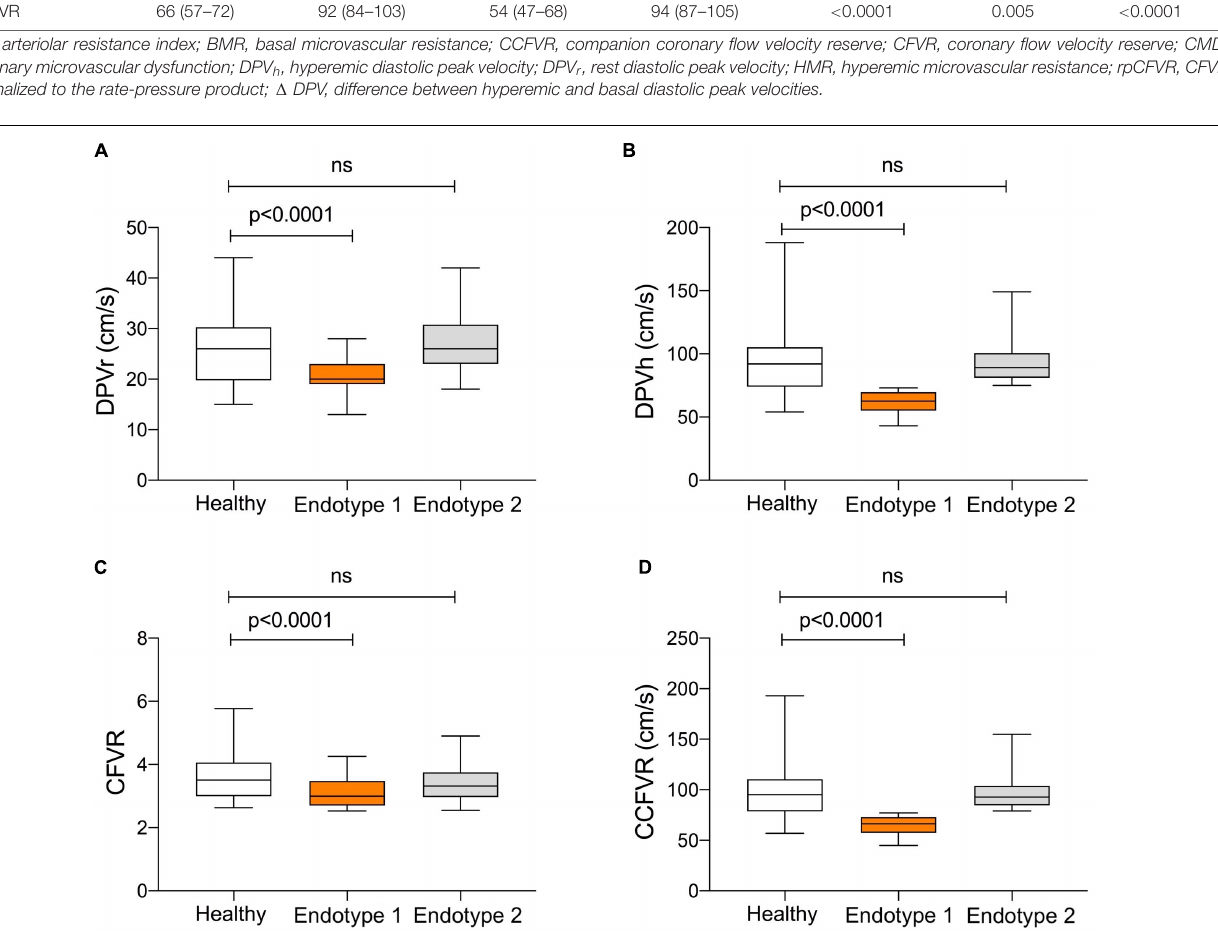
FIGURE 2 | Comparison of microvascular pattern in HT patients with preserved CFVR (endotype 1 and endotype 2) and control group. Endotype 2 and controls share a comparable microvascular pattern, while endotype 1 has significantly lower DPV r (Panel A ; p < 0.0001), DPV h (Panel B ; p < 0.0001), CFVR (Panel C ; p < 0.0001) and CCFVR (Panel D ; p < 0.0001). This figure highlights how, even among patients with preserved CFVR, there are substantial differences in coronary microvascular flow